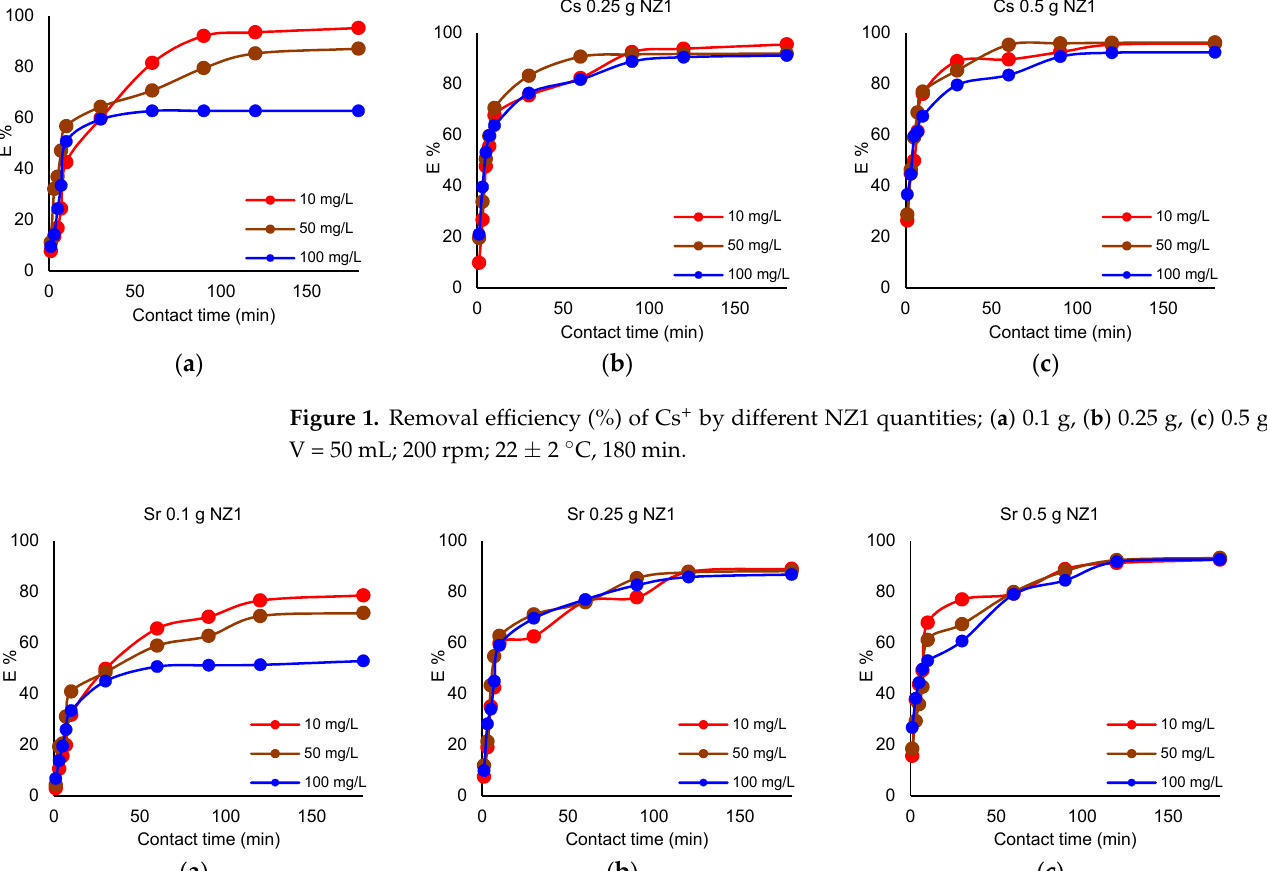
Figure 2. Removal e ffi ciency (%) of Sr 2+ by di ff erent NZ1 quantities; ( a ) 0.1 g, ( b ) 0.25 g, ( c ) 0.5 g; V = 50 mL; 200 rpm; 22 ± 2 °C, 180 min.